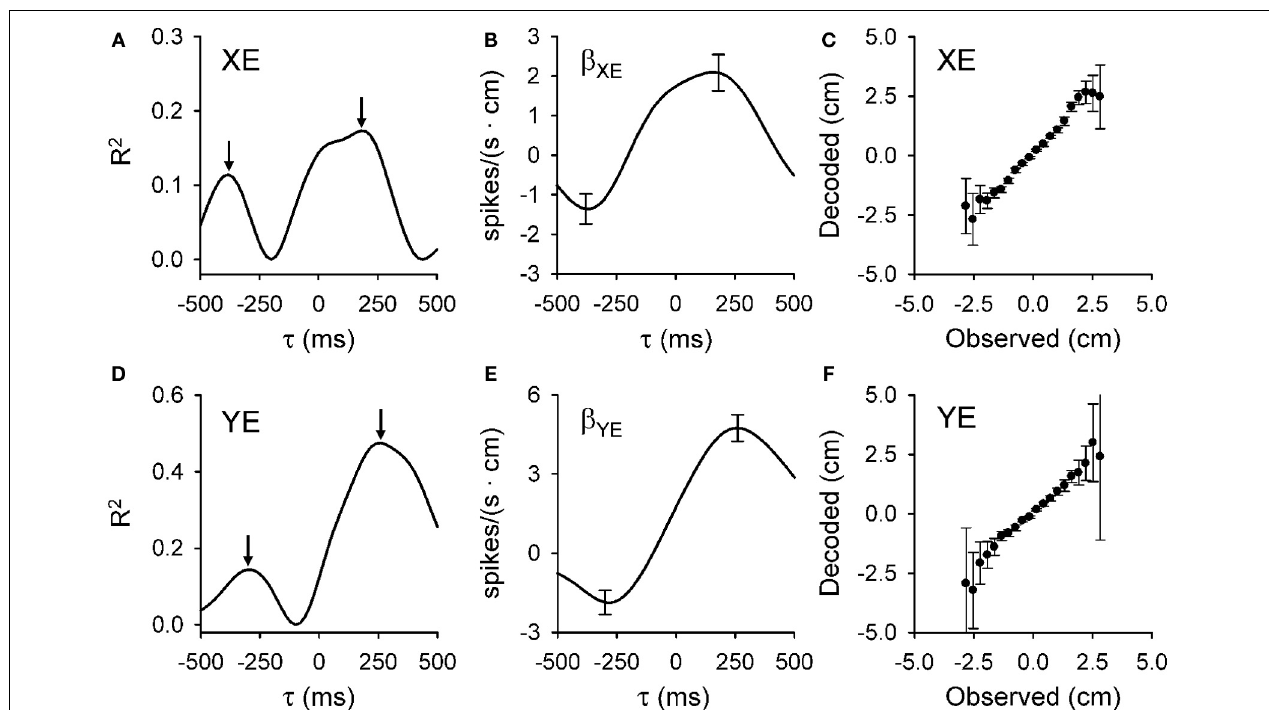
at predictive versus feedback timing. (C,F) Plot of the decoded upcoming XE and YE (mean ± SD ) versus observed based on the population of Purkinje cells. Slope of decoded estimate versus the observed is 0.99 ( ρ = 0 . 95, p < 0 . 001) for XE and 0.98 ( ρ = 0 . 83, p < 0 . 001) for YE showing the accuracy of the prediction. Decoding estimates were from 25 repetitions of the off-line decoding algorithm (see Popa et al., 2012). Plots are reproduced from Popa et al. (2012) with